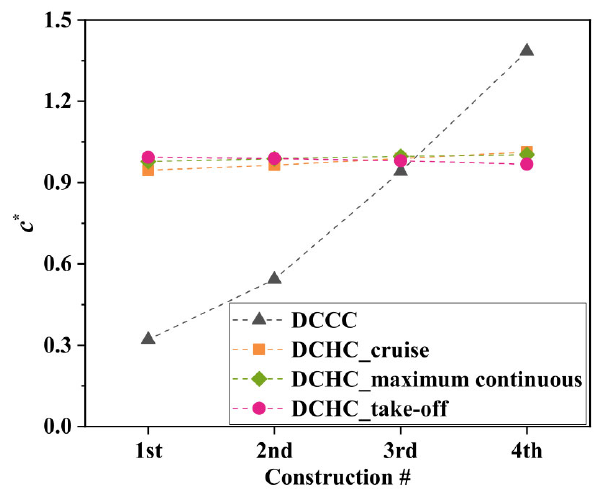
Figure 28. Profiles of DCCC and